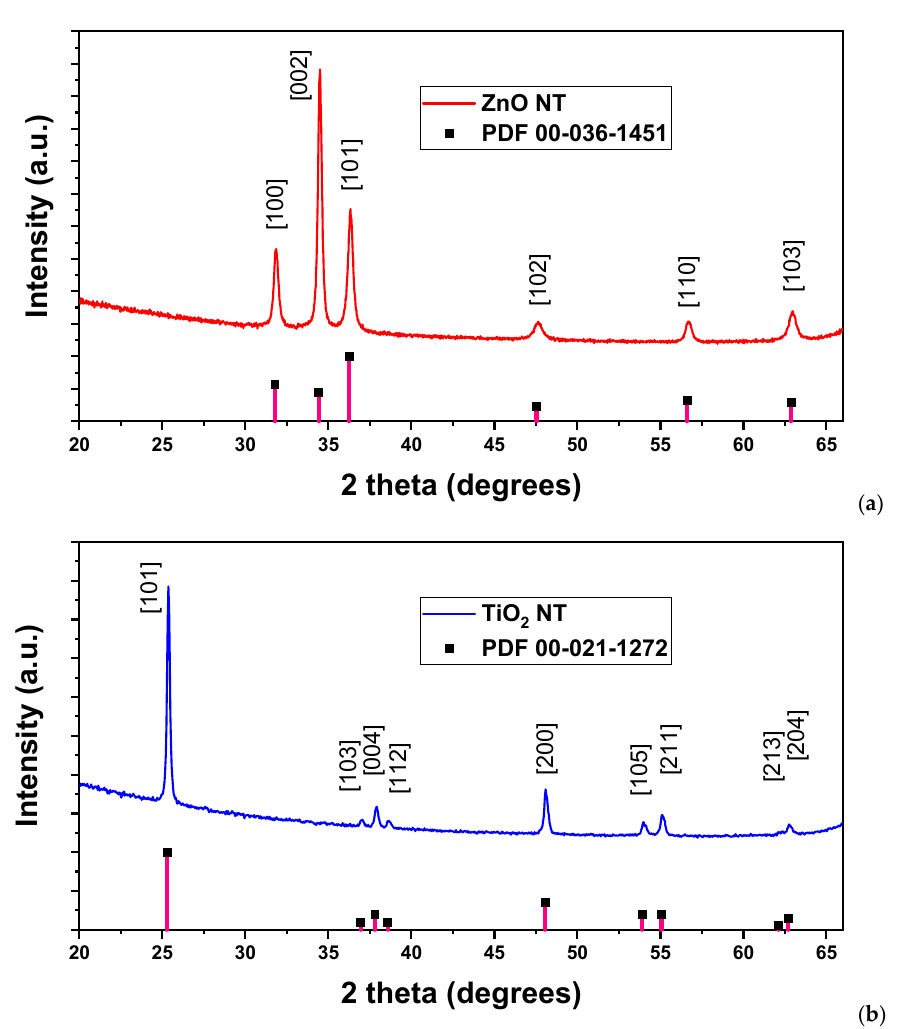
Figure 3. Diffractograms of ( a ) ZnO nanotubes and ( b ) TiO 2 nanotubes, obtained after sputtering and subsequent calcination.